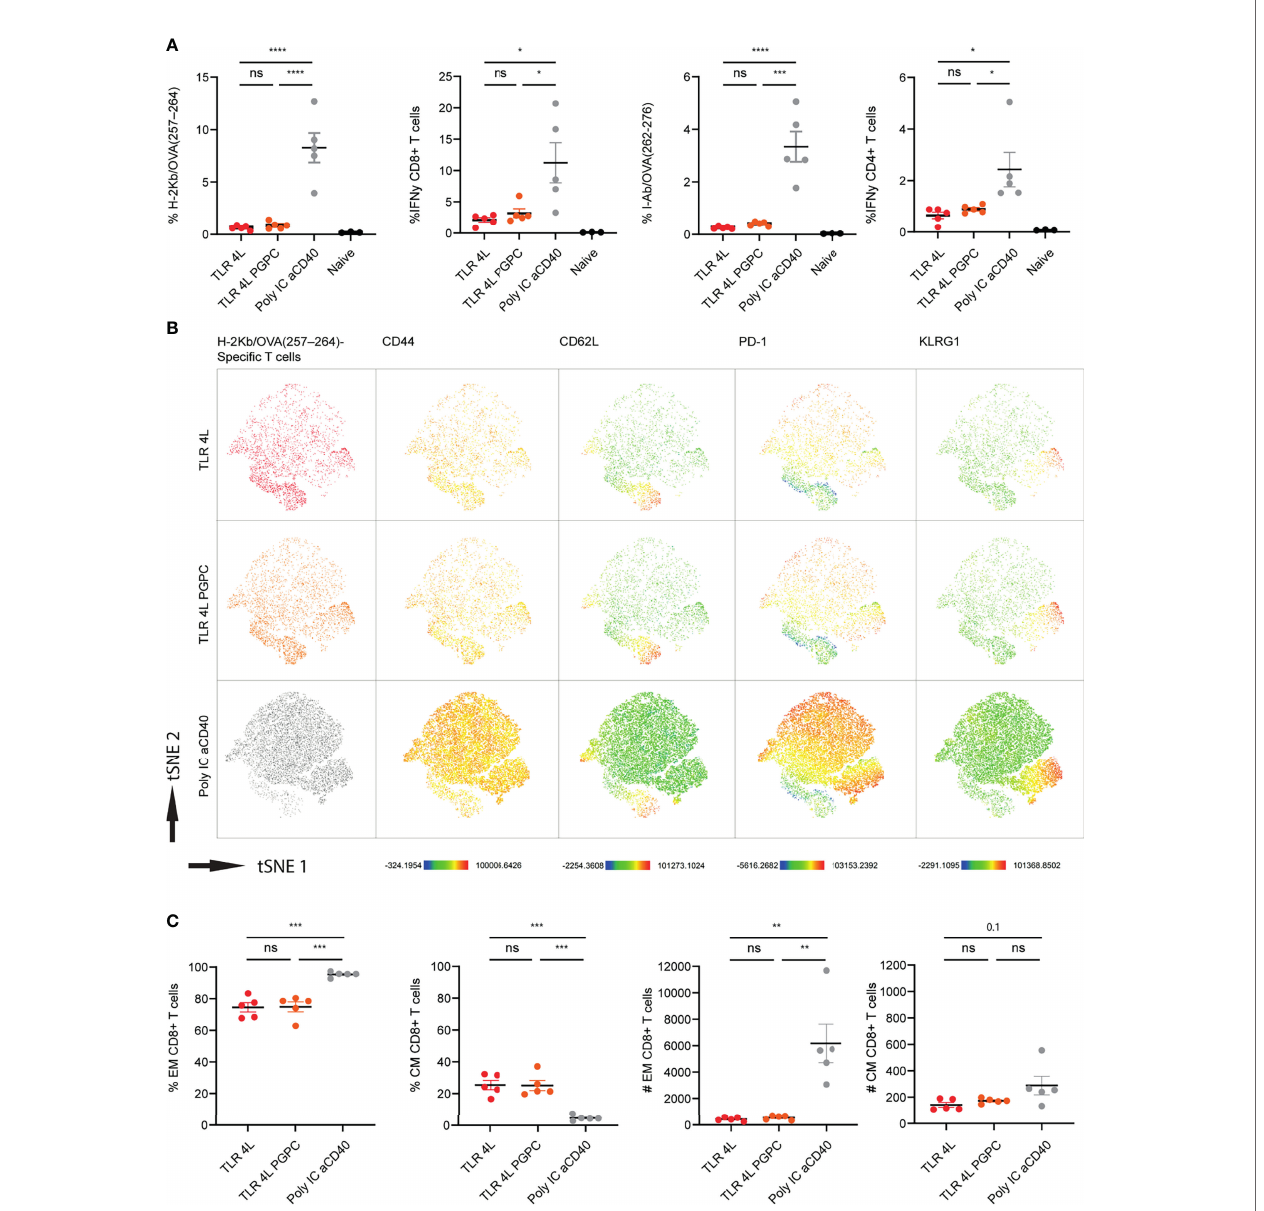
FIGURE 5 | Addition of PGPC does not augment the potency of TLR4L-containing GM3 liposomes. (A) Mice were i.v. injected with different liposome formulations, or antigen-containing liposomes with poly IC and aCD40 antibody as soluble adjuvant as a positive control, or left uninjected (naive). 7 days after injection, spleens were collected and a single cell suspension was used for tetramer staining or peptide restimulation. Indicated is the average ± SEM of the percentage of IFN g − producing CD8 + and CD4 + T cells upon peptide restimulation and CD8 + and CD4 + tetramer binding cells ( n = 3-5). (B) H-2Kb/OVA 257-264 binding T cells as identi fi ed in A were clustered using high-dimensional data reduction. H-2Kb/OVA 257-264 binding T cells are indicated (groups were indicated with different colors in the fi rst column), as well as their expression levels of CD44, CD62L, PD-1 and KLRG1. (C) H-2Kb/OVA 257-264 binding T cells were subdivided in CD44 + Tem and CD44 + CD62L + Tcm cells. Indicated is the average ± SEM of the percentage (of antigen-speci fi c CD8 + T cells) and number of cells identi fi ed as Tem or Tcm (based on 10 6 events) ( n = 5). *p < 0.05, **p <0.01, ***p < 0.005 and ****p < 0.0001. ns, not signi fi